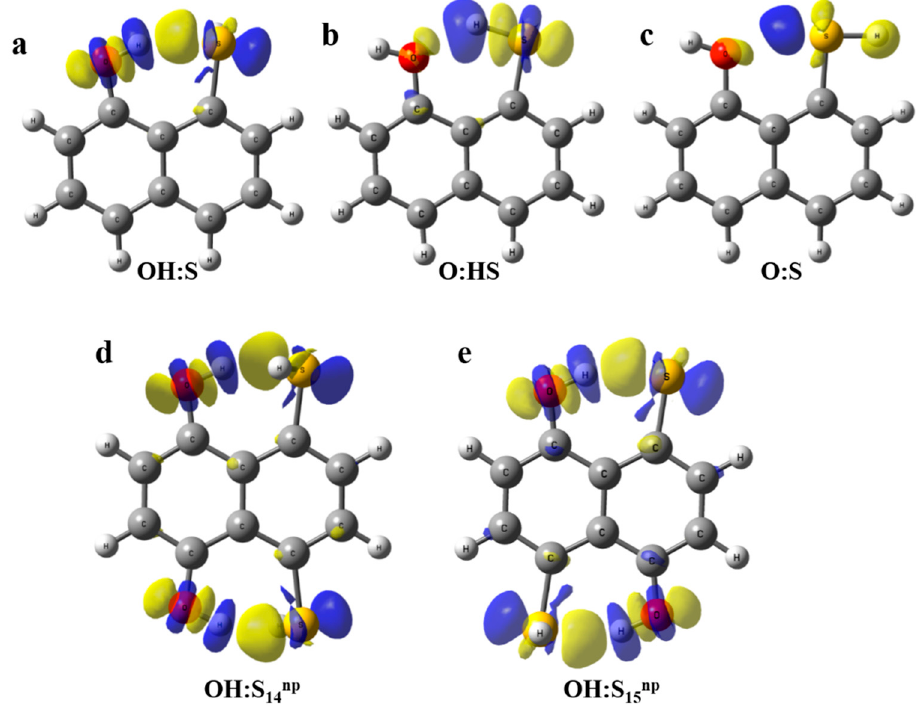
Figure 4. Electron Density Shifts maps at 0.001 a.u. calculated for complexes ( a ) OH:S, ( b ) O:HS, ( c ) O:S, ( d ) OH:S 14np and ( e ) OH:S 15np .